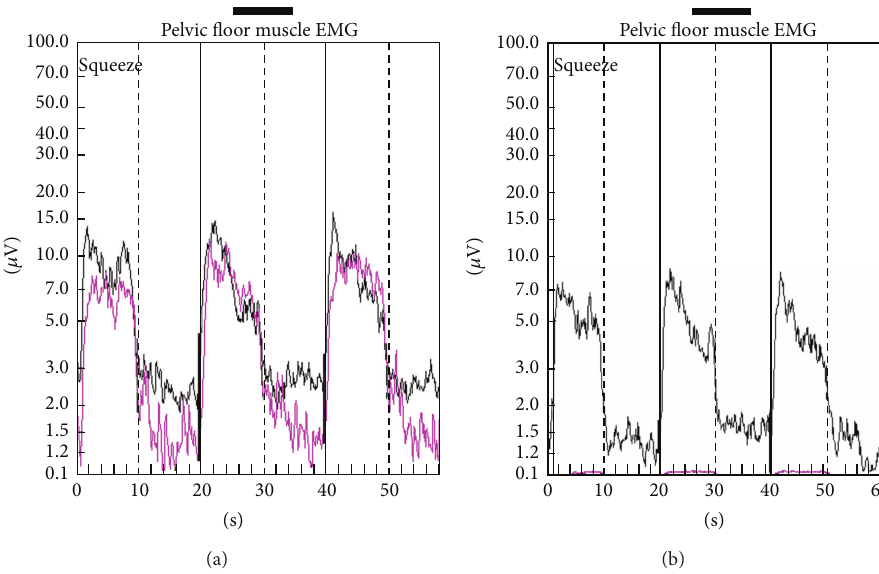
Figure 1: Muscle isolation. (a) Electromyographic tracings of a patient with outlet obstruction defecation and anismus with excessive accessory muscle utilization (pink tracing) corresponding to contraction and relaxation of the pelvic floor complex. (b) Electromyography of the same patient following sessions of pelvic muscle rehabilitation revealing significant reduction of accessory muscle utilization during pelvic floor muscle contraction.